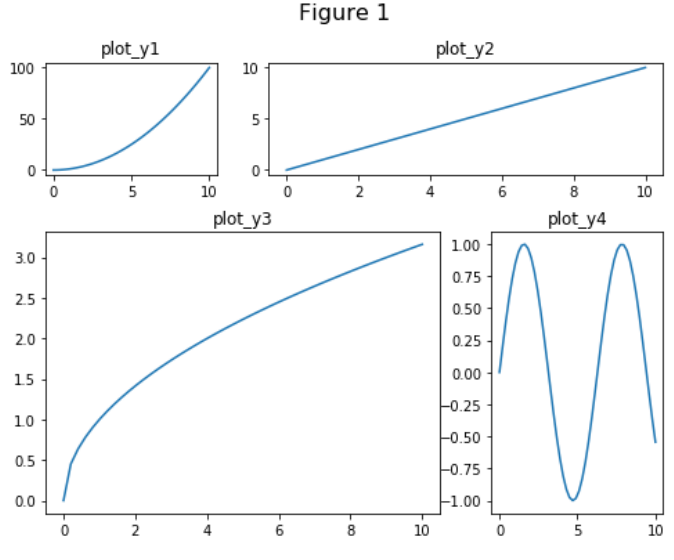
Figure 2.27: The output of Listing 2.60